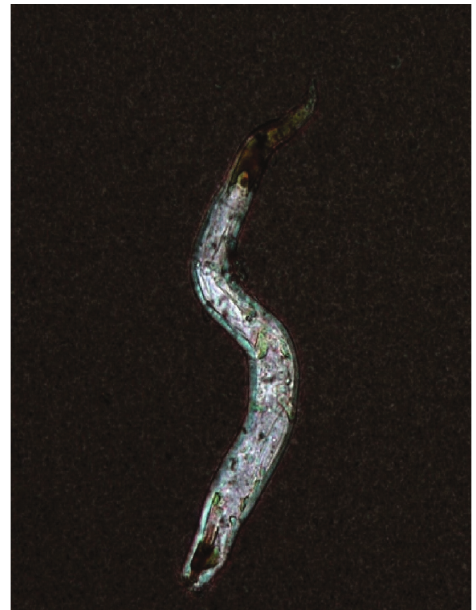
Figure 1: Rhabditiform larva of Strongyloides stercoralis recovered from cerebrospinal fluid sediment (India ink,